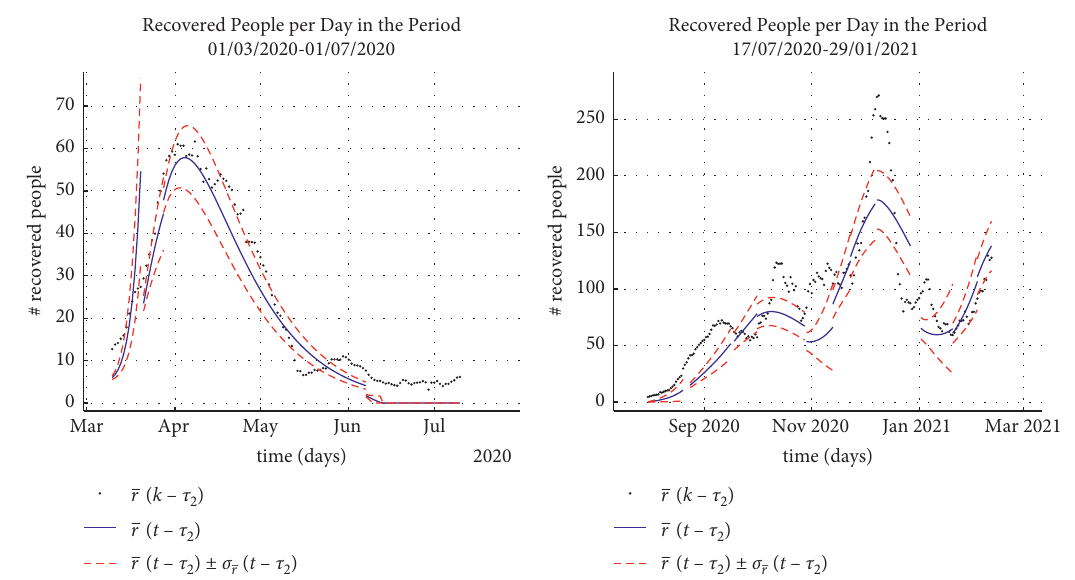
Figure 10: Comparison between recovered people per day (black dots) with respect to the estimation (blue solid line) carried out with the estimated parameters. The dashed red lines show the standard error of the solution.